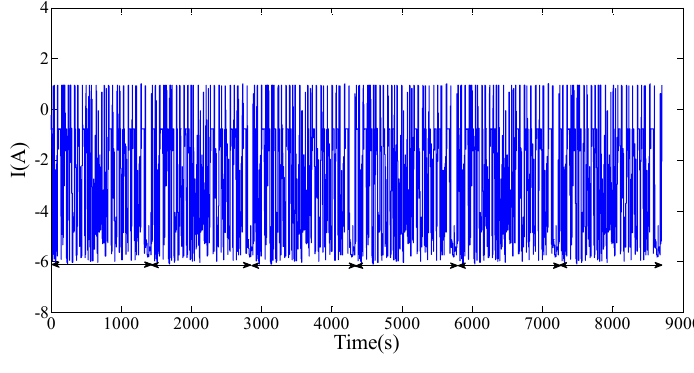
Figure 10. Current during the UDDS test.